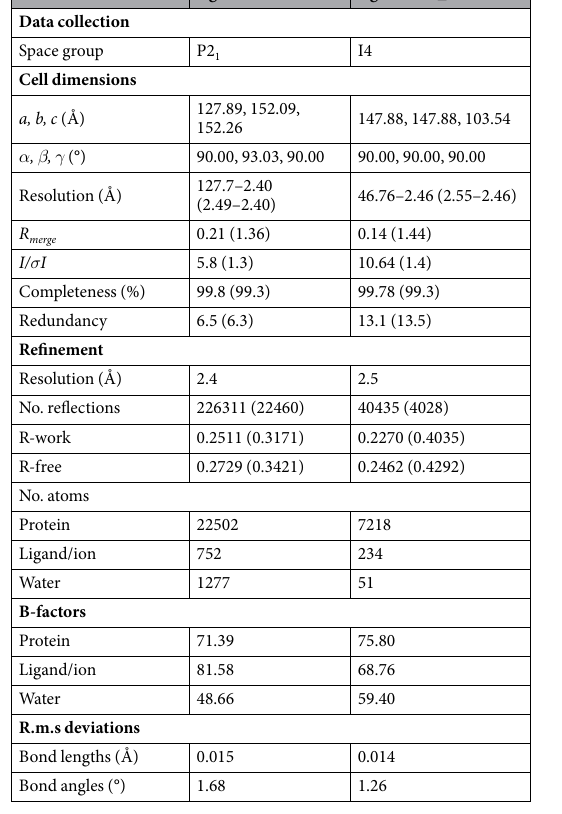
Table 1. X-ray crystallography data collection and refinement statistics. Statistics for the highest-resolution shell are shown in parentheses. Friedel mates were averaged when calculating reflection statistics. Data for both structures were collected using a single